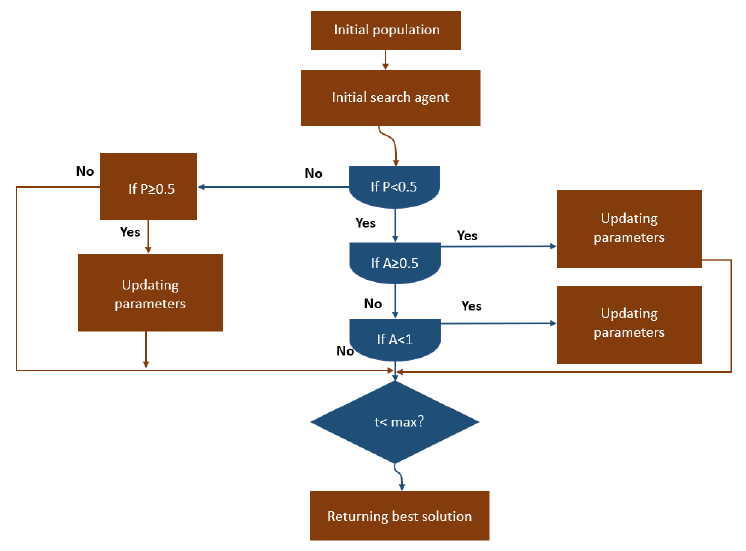
Figure 19. Steps in the WOA.